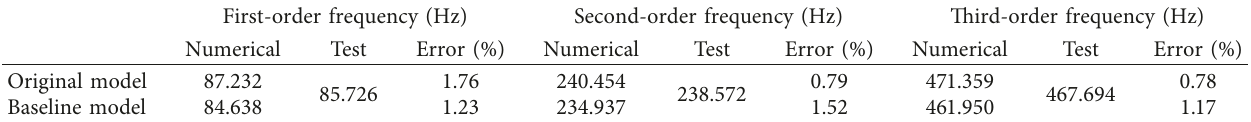
Table 8: Frequencies of the undamaged